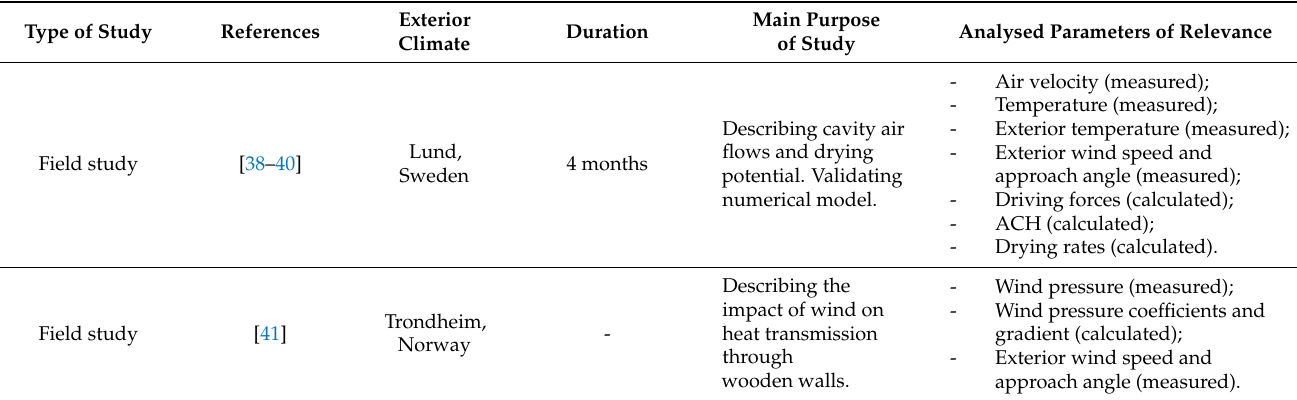
Table 1. Overview of